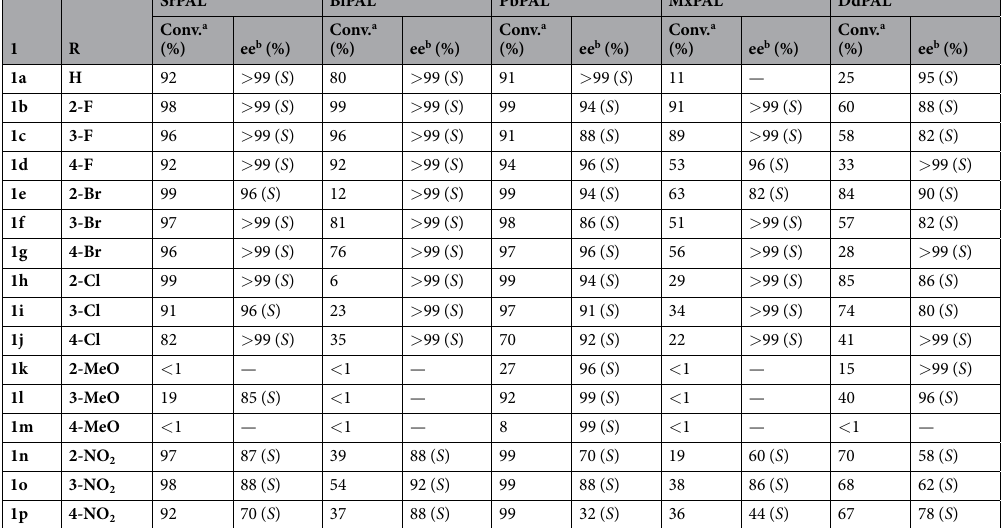
Table 2. PAL-catalysed amination of various ring-substituted phenylacrylate derivatives. a Determined